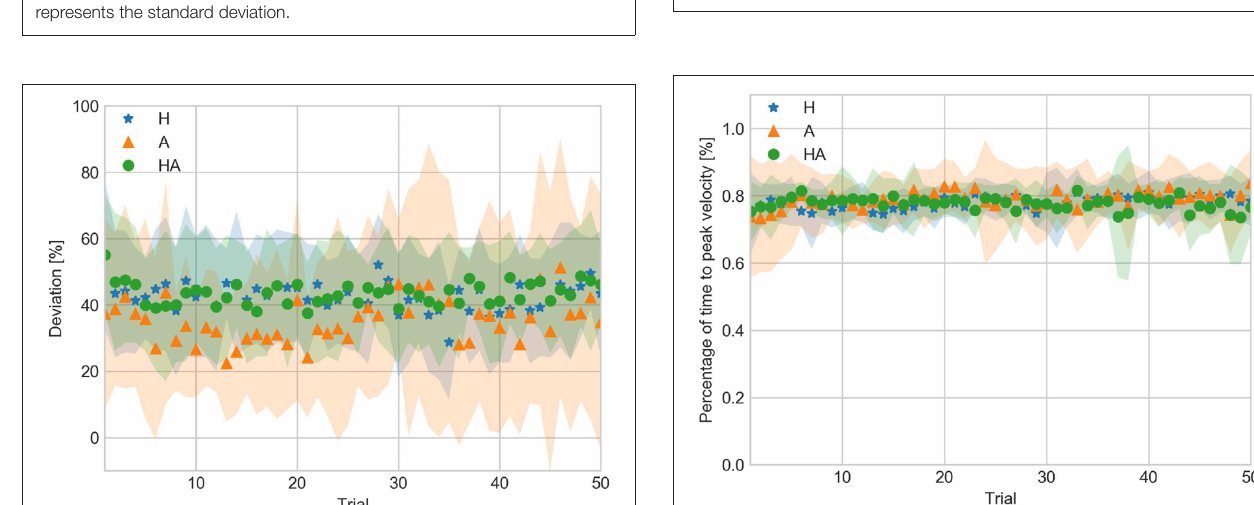
FIGURE 7 | Ratio of contact to peak velocity against trial number averaged over all subjects for the haptic (H), acoustic (A), and haptic-acoustic (HA) conditions. The contour represents the standard deviation.